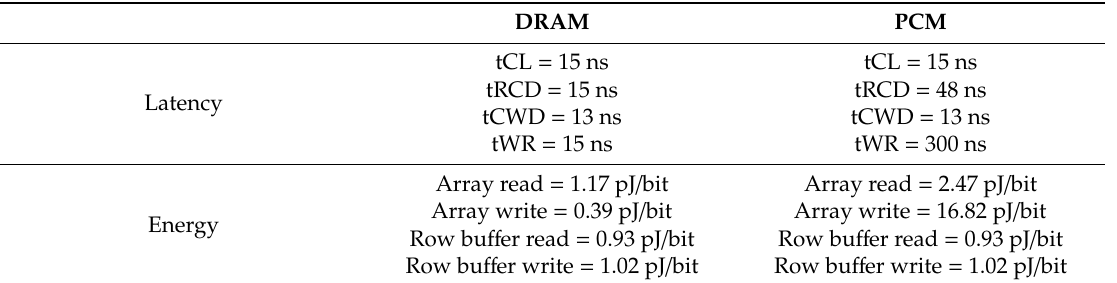
Table 2. DRAM and PCM